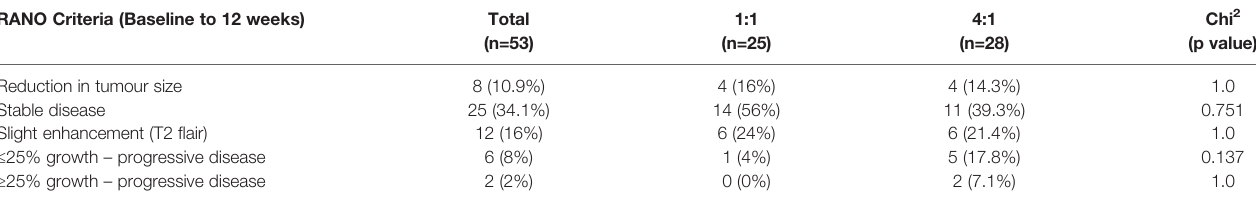
TABLE 5 | Comparison between the two groups from MRI results with Chi Square